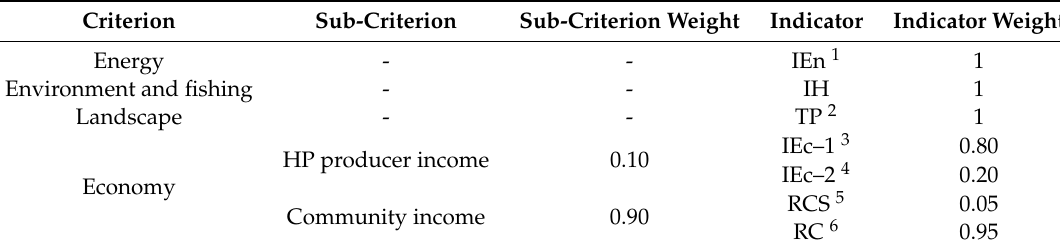
Table 2. Weights assigned by the TAB members to the economic sub-criteria and to all the indicators considered in the Graines case